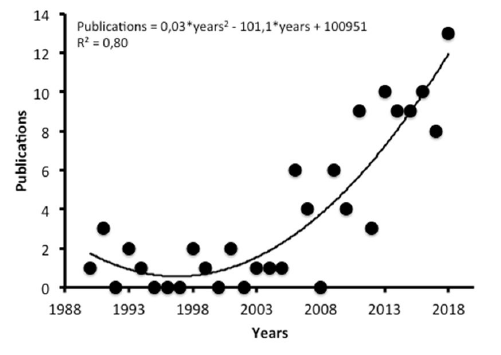
Figure 2. Number of publications on decomposition in subtropical South American aquatic environments